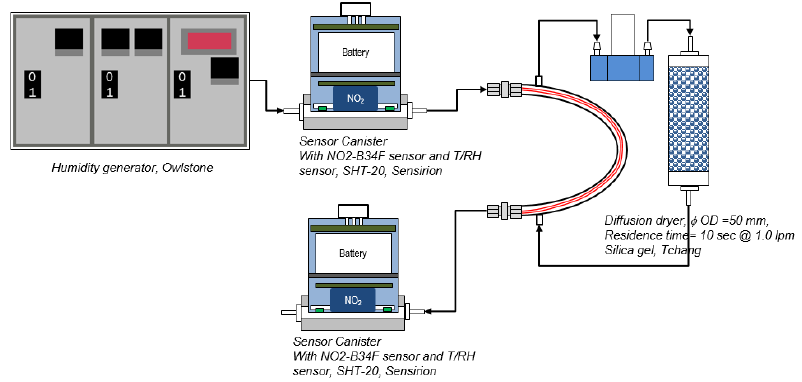
Figure 2. Setup of humidity equilibrium test of Nafion tube with a humidity generator.